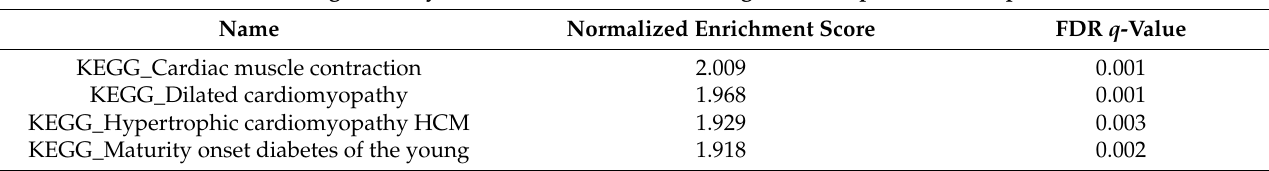
Table 2. Gene set enrichment